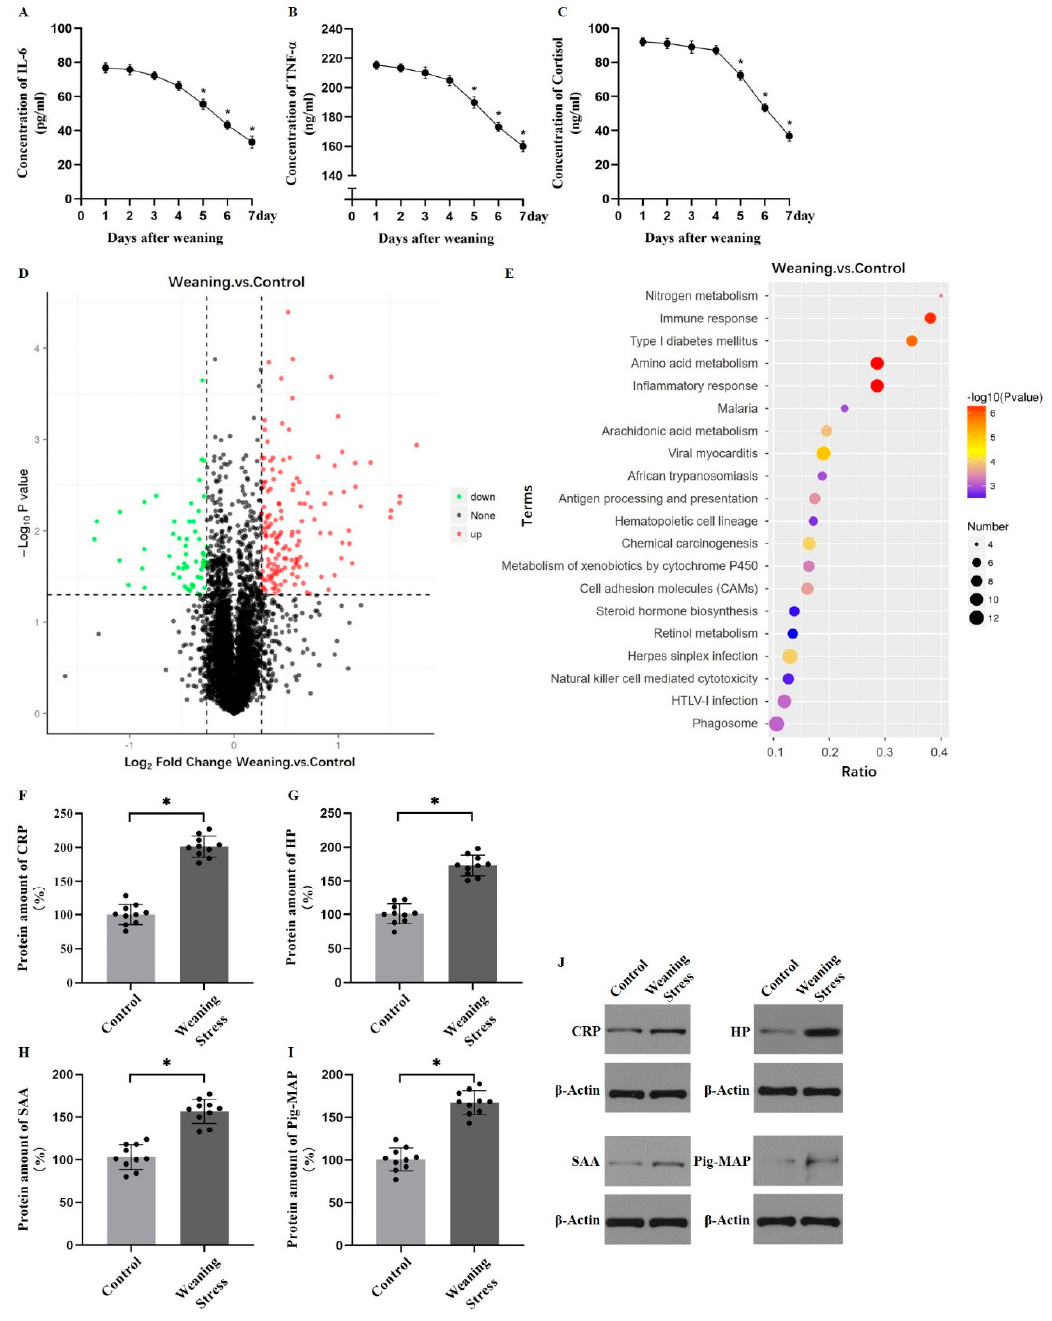
Figure 1. Weaning stress reduces the content of hepatic aromatic amino acids in piglets. ( A – C ) Plasma concentration of IL-6 (pg / mL), TNF- α (ng / mL), and cortisol (ng / mL) after weaning at day 1 to day 7. ( D ) Di ff erentially expressed proteins between weaning and control group were shown by volcano plot. Red dots indicate proteins that are up-regulated, and green dots indicate proteins that are down-regulated. ( E ) KEGG analysis between the weaning group and control group. ( F – J ) Hepatic C-reactive protein (CRP), haptoglobin (HP), Pig-major acute phase protein (Pig-MAP), and Serum amyloid A (SAA) protein levels in pigs liver. (Data are mean ± SD; n = 10 and * p < 0.05).